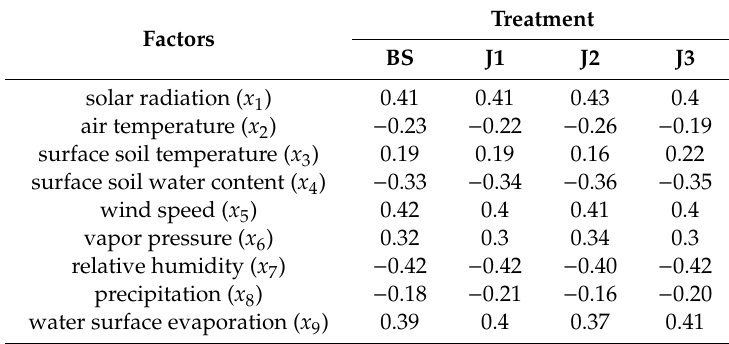
Table 4. Weight coe ffi cient of factors in F1 during the stable freezing stage (P2).